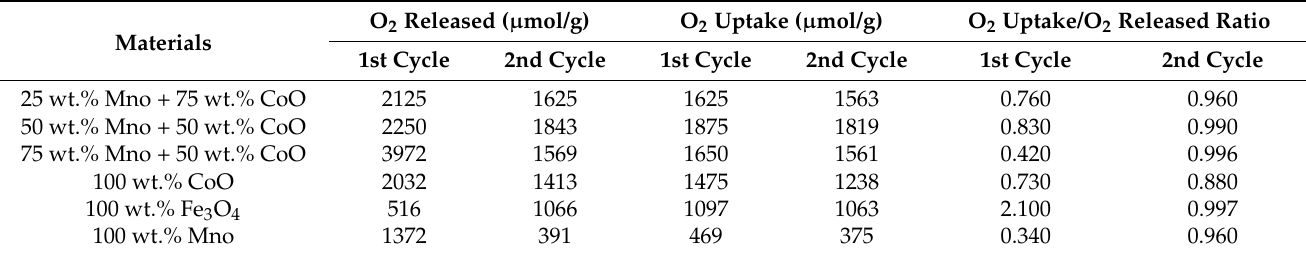
Figure 4. The oxygen uptake ratio in both cyclic redox reactions at 30 mL Ar/min and 20 mL O 2 /min gas flow rates subjected to heating from 30 to 1400 ◦ C at 30 ◦ C/min heating rate and cooling to 800 ◦ C for two-cyclic redox reactions. Table 3. The oxygen uptake and release ratio metallic oxides during redox